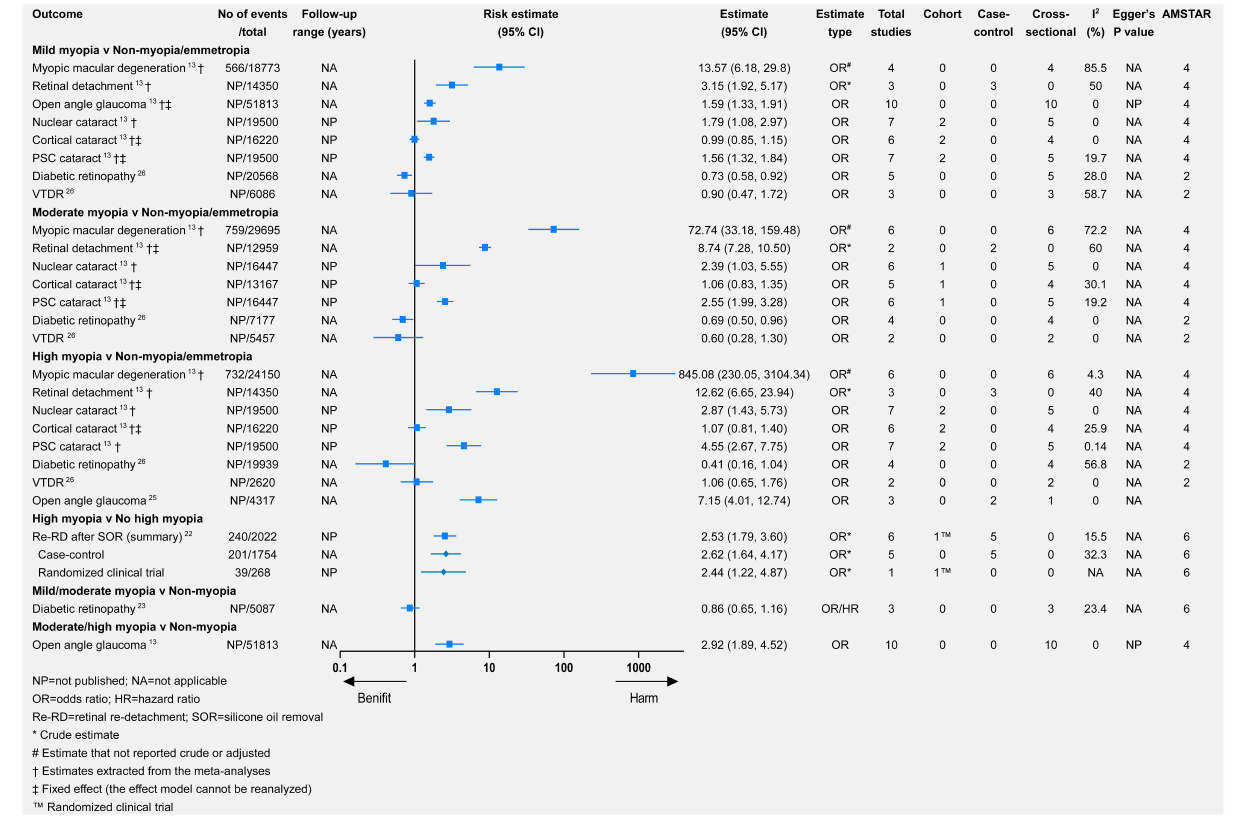
FIGURE 3 | Associations of different myopia types with multiple eye health outcomes.